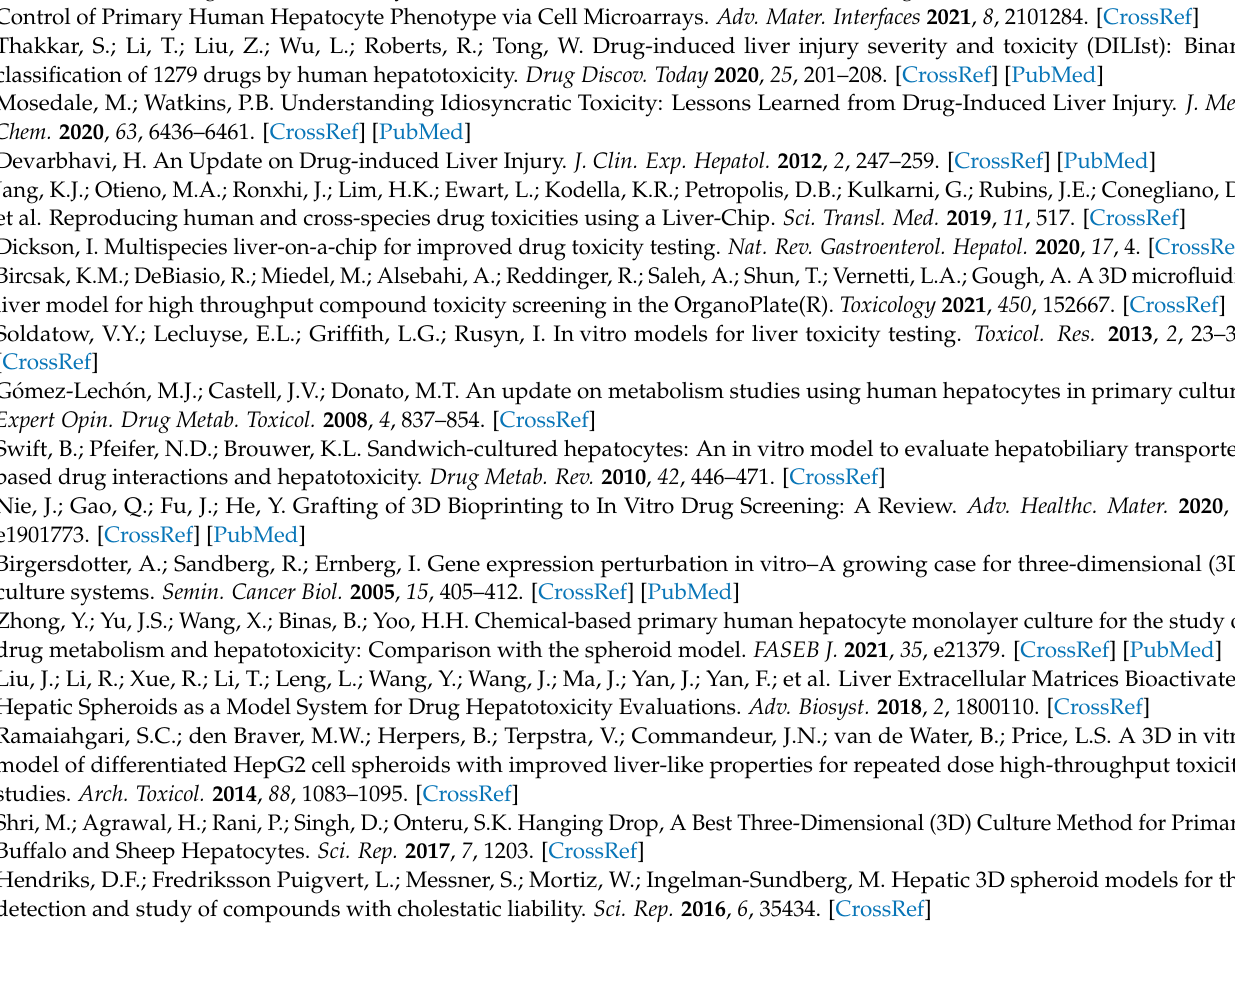
human serum albumin measured by ELISA. (B) Standard curve of ATP measured by ELISA. Table S1: The preparation of albumin-based cryogels with three different concentrations. Table S2: List